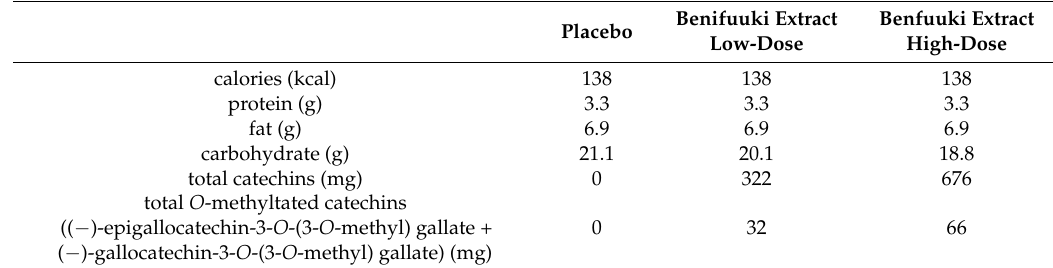
Table 1. Nutritional profile and catechins and caffeine content of the test ice cream provided per day.